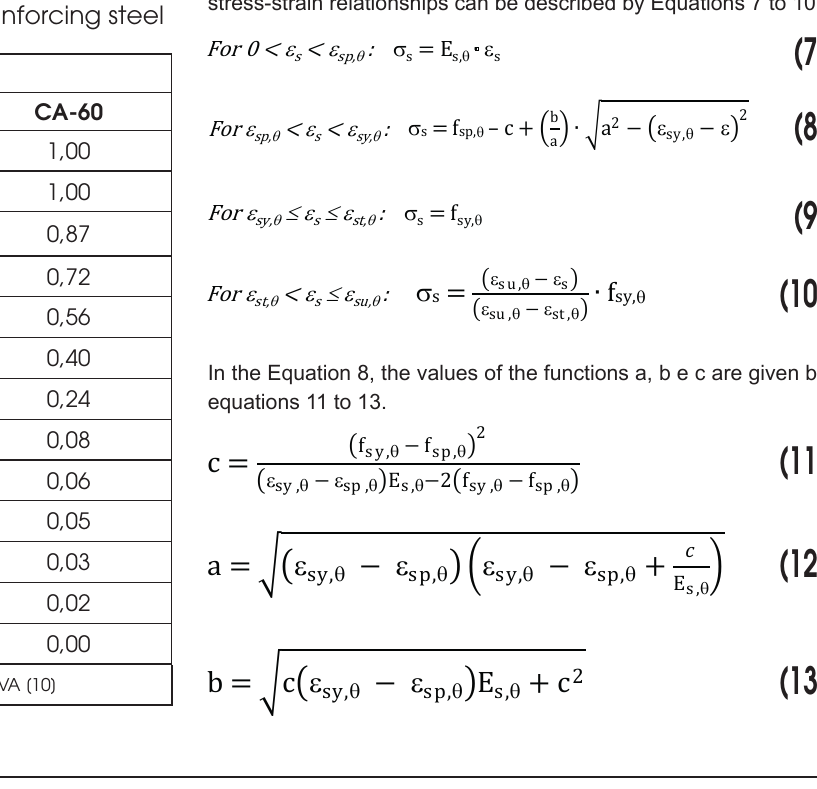
Figure 5, and may be obtained by Equation 6. In the Equation 6, E modulus of elasticity of reinforcing steel at room ambient, s k reduction factor for the modulus of elasticity of reinforcing sE,θ steel, taken from Table 4.